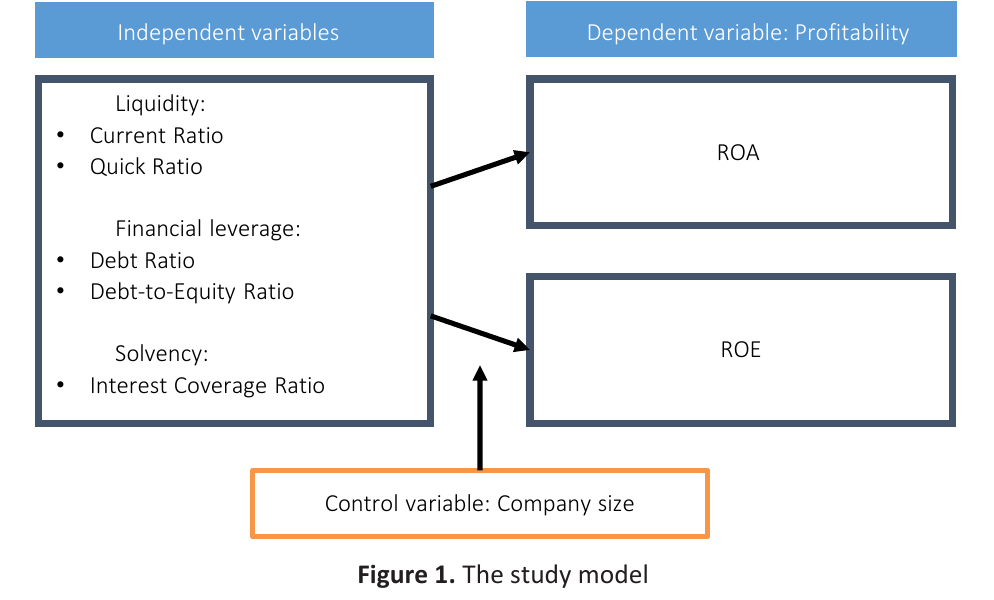
Figure 1. The study